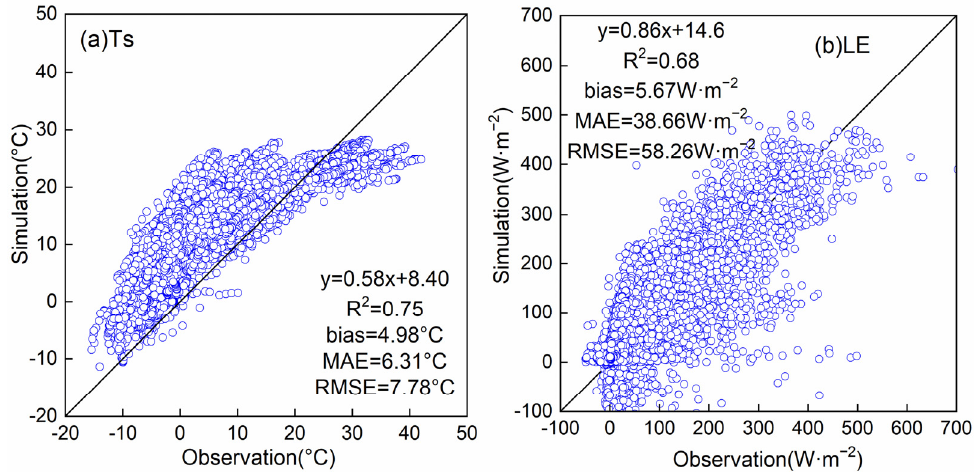
Figure 4. Scatter plots of Ts and LE over benchmark run.